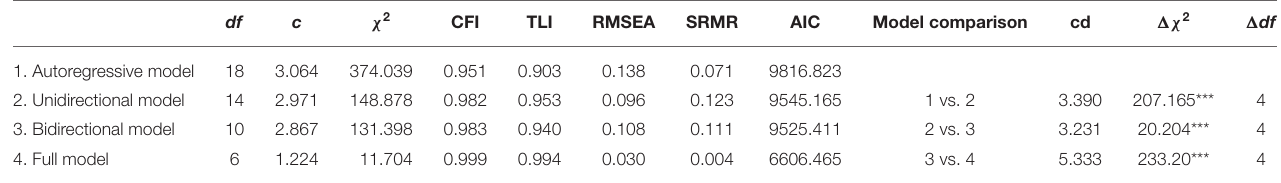
TABLE 3 | Model fit indices of parental care, depressive symptoms, and POGU. df c χ 2 CFI TLI RMSEA SRMR AIC Model comparison cd 1χ 2 1 df